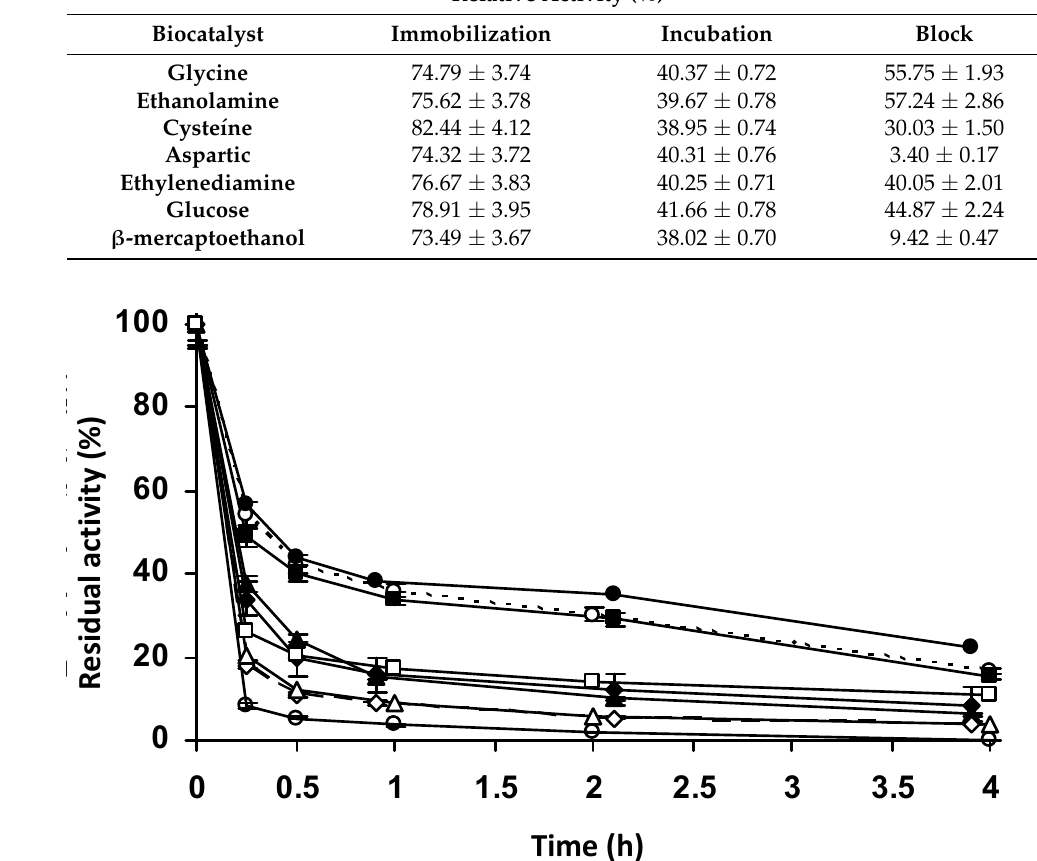
Figure 11. Effect of different blocking agents on the stability of the enzyme penicillin G acylase immobilized at high ionic strength on vinyl sulfone agarose. Immobilization was carried out in 50 mM sodium phosphate pH 7.0 and incubation at pH 10.0. Empty circles with dashed line: glyoxyl agarose as a reference. Full circle with solid line: ethanolamine. Full squares with solid line: glycine. Empty squares with solid line: β -mercaptoethanol. Full rhombi with solid line: cysteine. Full triangle with solid line: control without blocking agent as a reference. Empty triangles with solid line: glucose. Empty rhombi with solid line: ethylenediamine. Empty circles with solid line: aspartic acid. Other specifications are described in the Methods.